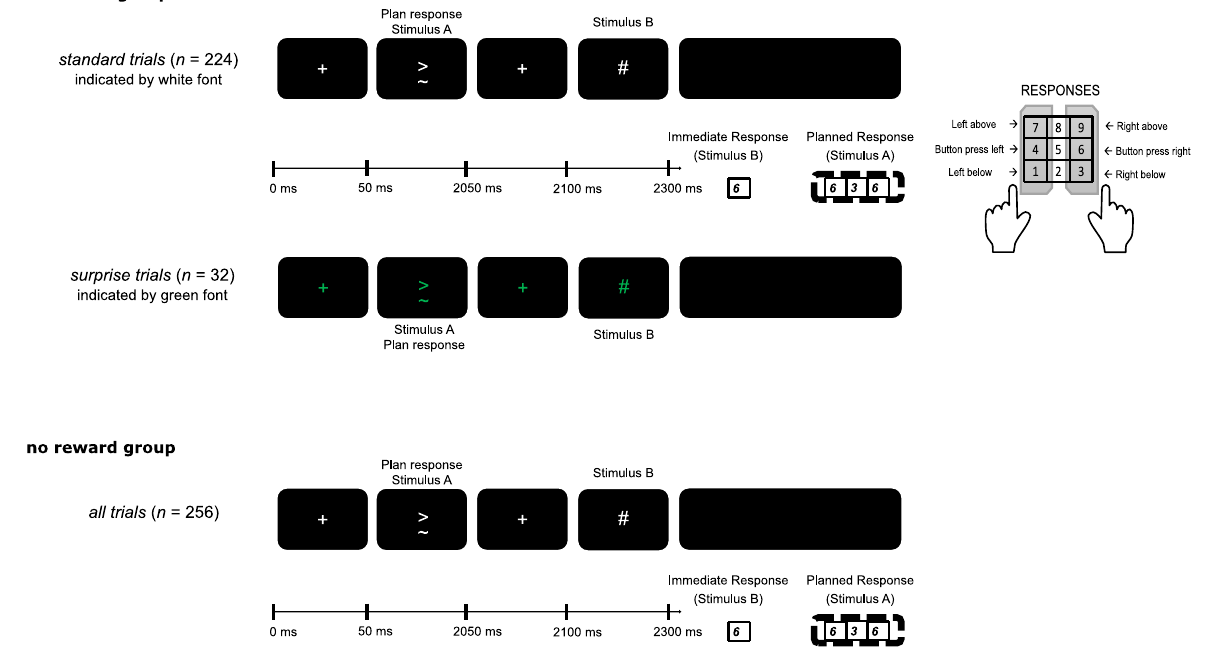
Figure 1. Schematic illustration of the R-R task. Stimulus and event timing as well as the response layout is depicted. Participants responded by using the numerical pad on a keyboard. The buttons of “1”, “4” and “7” were used for left responses, and “3”, “6” and “9” for right responses. Participants were instructed to use their left index finger on the left side of the pad, and their right index finger on the right side of the pad. For standard trials, stimuli are presented with white font color, green color was used for surprise trials (only rewarded group, top). In the no reward group (bottom), white font color was